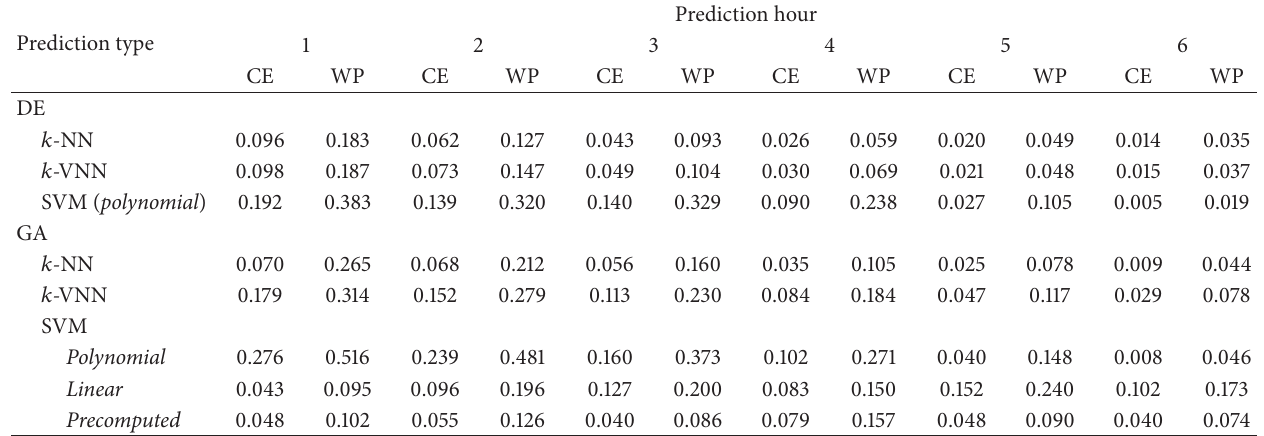
Table 7: Experimental results (1–6 hours) by